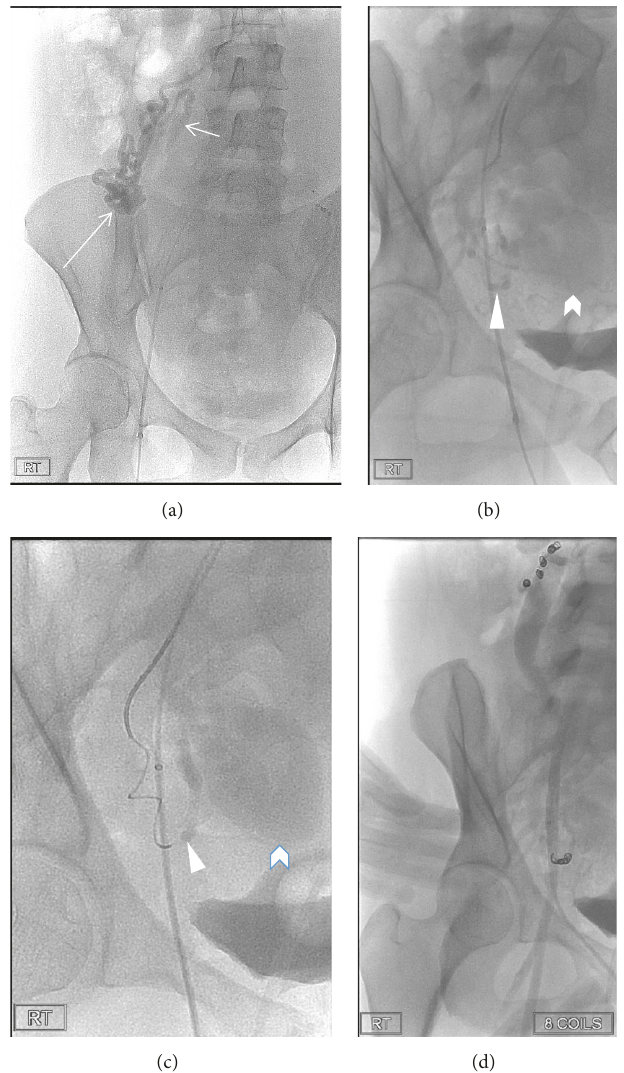
Figure 6: Interventional fluoroscopic images. (a) Tortuous right ovarian artery off the aorta (long arrow) with perforating branch into the myometrium (short arrow). Faint blush of pseudoaneurysm on real-time imaging (not shown). (b) Selected right hypogastric artery showing uterine branch (arrowhead) leading to faint oval blush of pseudoaneurysm (chevron). (c) Subselected uterine artery feeder (arrowhead) and pseudoaneurysm blush (chevron). (d) Postcoiling images of parasitized right ovarian and uterine arteries without flow to the target lesion.